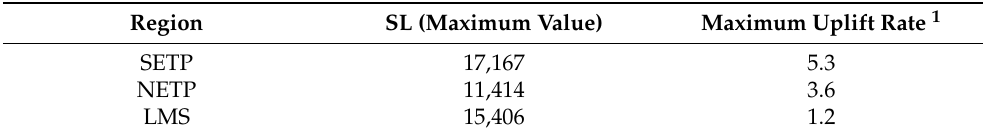
Table 2. Comparison of SL values in the SETP with other parts of the Tibetan Plateau: the northeastern Tibetan Plateau (China) (NETP), and the Longmenshan thrust belts (LMS) in the eastern Tibetan Plateau